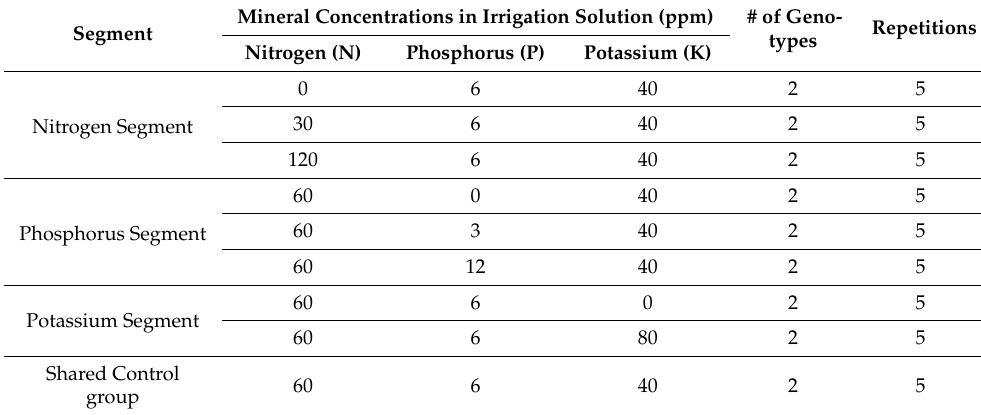
Table A2. List of treatments in summer field experiment, including N treatments reported by Gashu et al.